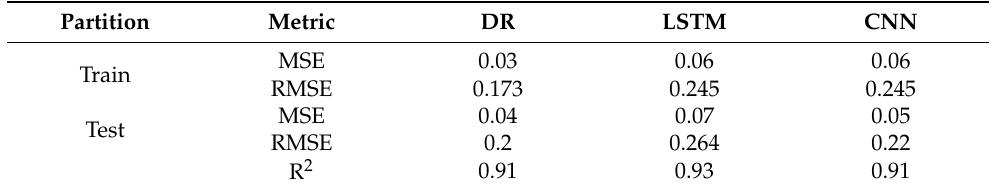
Table 2. Average error obtained with the first cross-validation.